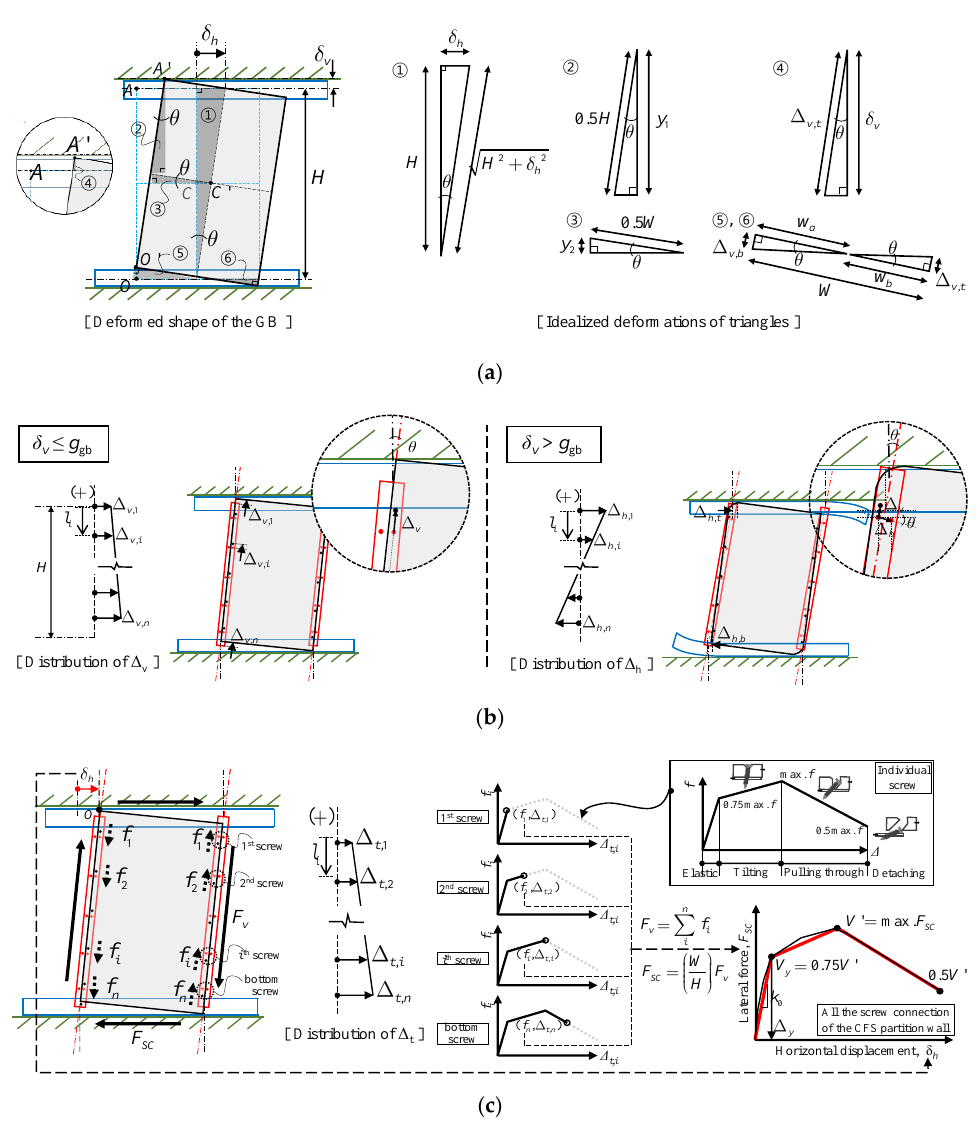
Figure 3. Monotonic behavior of a screw connection: ( a ) deformed shapes of the gypsum board (GB); ( b ) relative deformation; ( c ) load-bearing capacity.